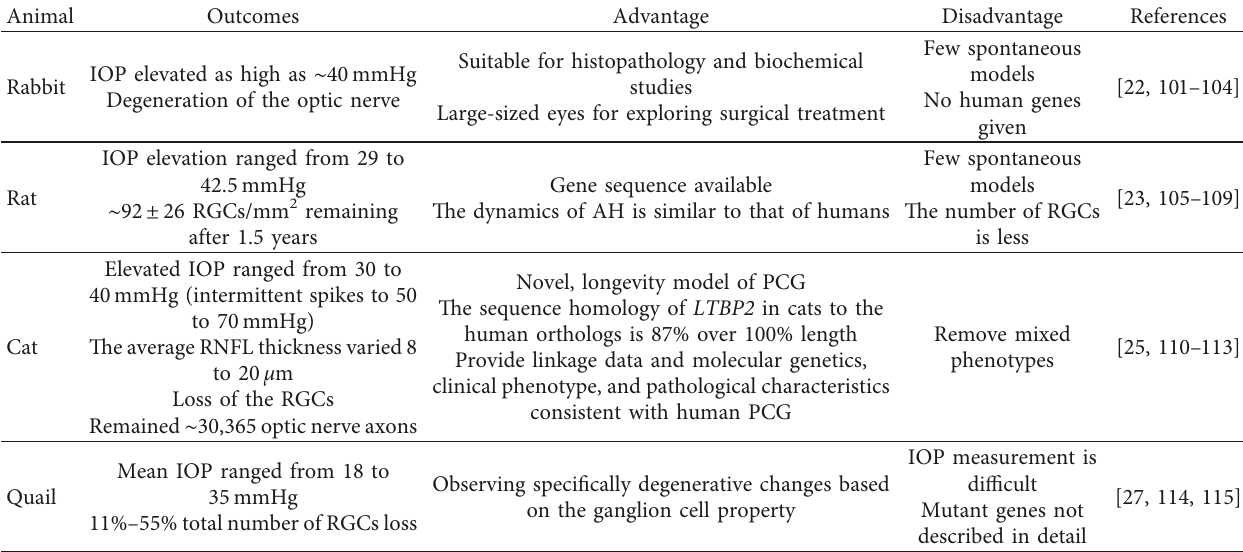
Table 2: The advantages and disadvantages of spontaneous animal models with PCG. Animal Outcomes Advantage